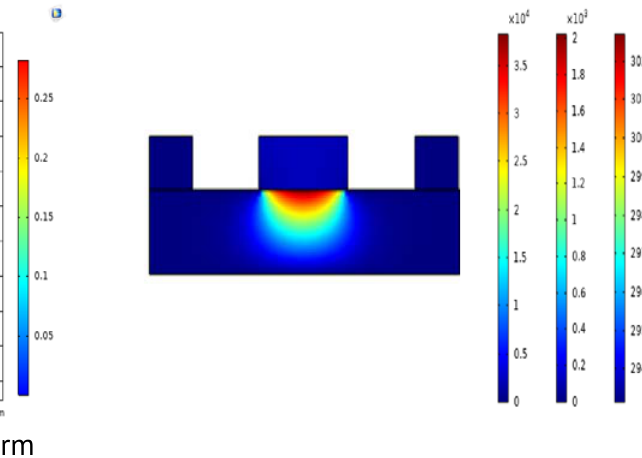
Figure 4. Magnetic flux density norm